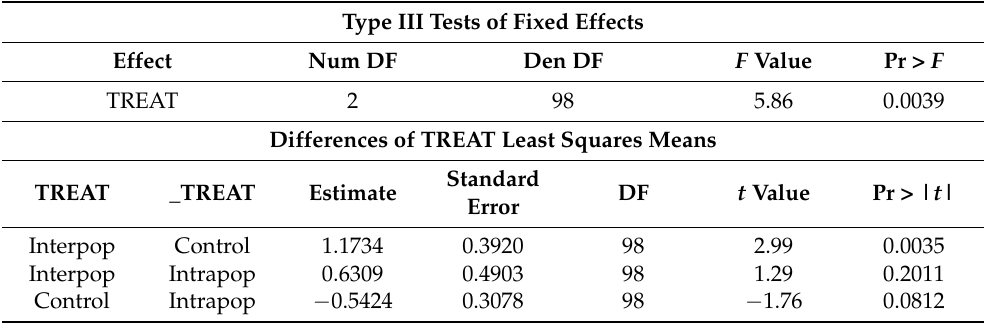
Table A1. Fruit Set (fruit number/flower